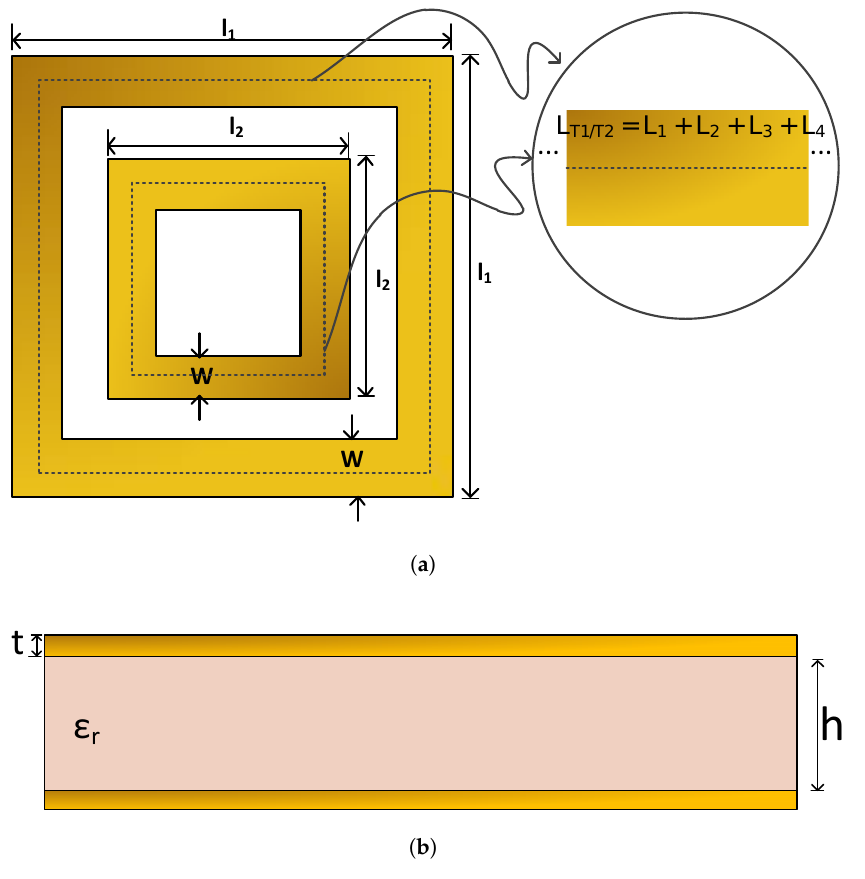
Figure 4. Proposed metasurface unit cell. ( a ) Top View; ( b ) Perspective